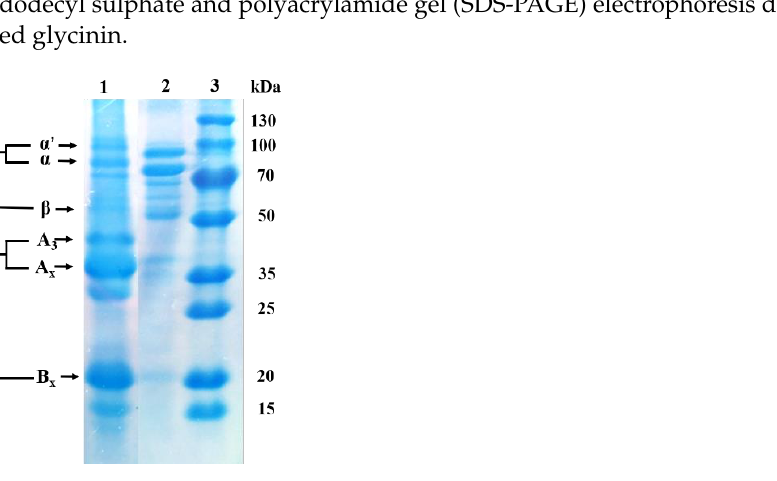
Table 4. Formulation and nutritional composition of experimental feeds (air-dry basis).